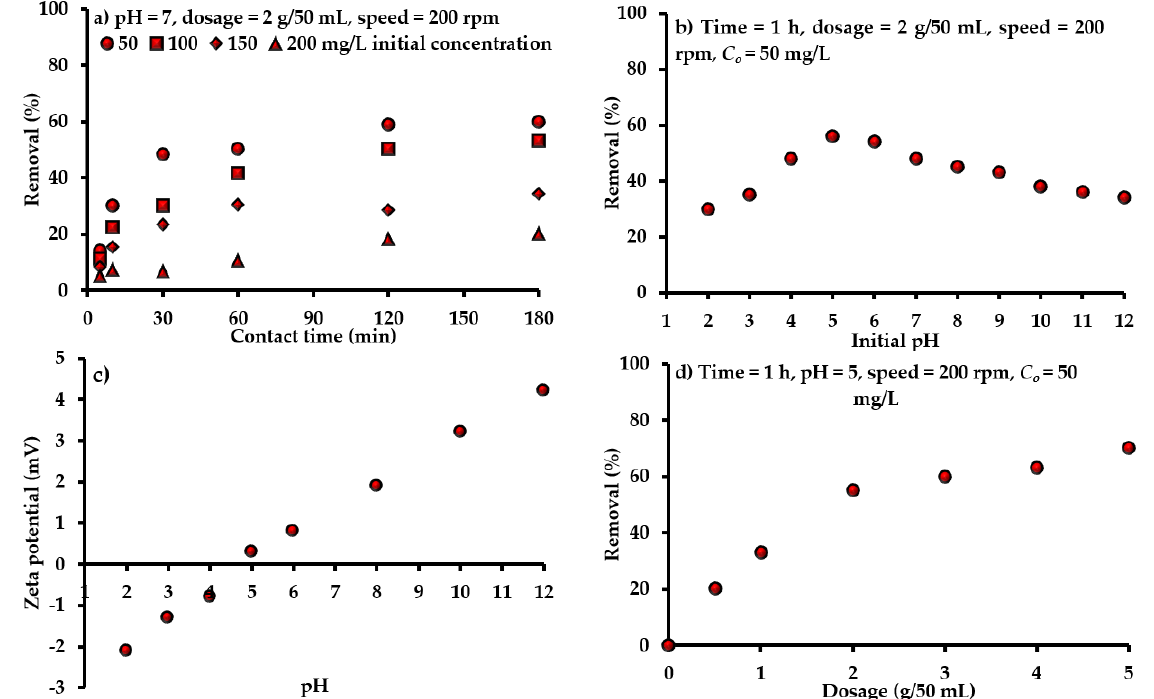
Figure 2. Influence of ( a ) time and C o , ( b , c ) pH and ( d ) sorbent dosage on the efficacy of prepared composite sorbent under different operational conditions.